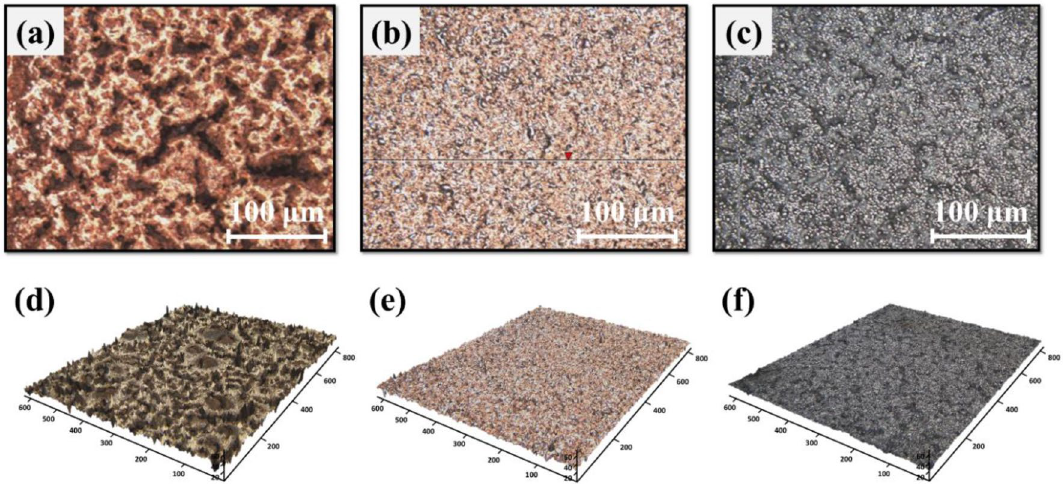
Figure 6. Surface morphology observations of ( a ) IPL sintered Cu NP electrode, ( b ) IPL sintered CPN electrode, and ( c ) Ni electroplated CPN electrode (S-16). Optical 3D profile images of an ( d ) IPL sintered Cu NP